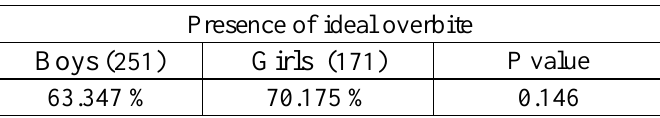
Table 8: gender differences in the presence of primary dentition ideal over